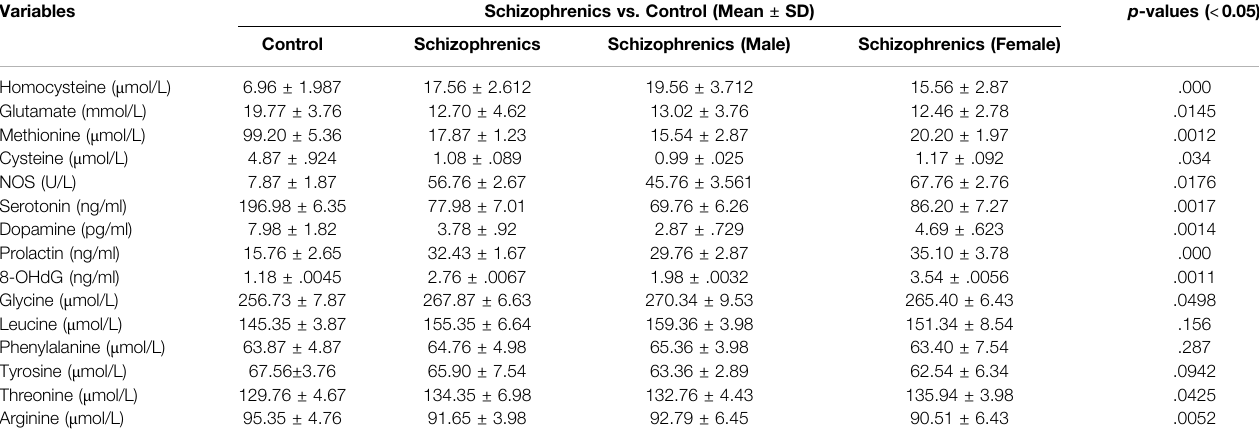
TABLE 8 | Amino acids and hormonal pro fi le of schizophrenics versus controls. Variables Schizophrenics vs. Control (Mean ± SD) p -values ( < 0.05)